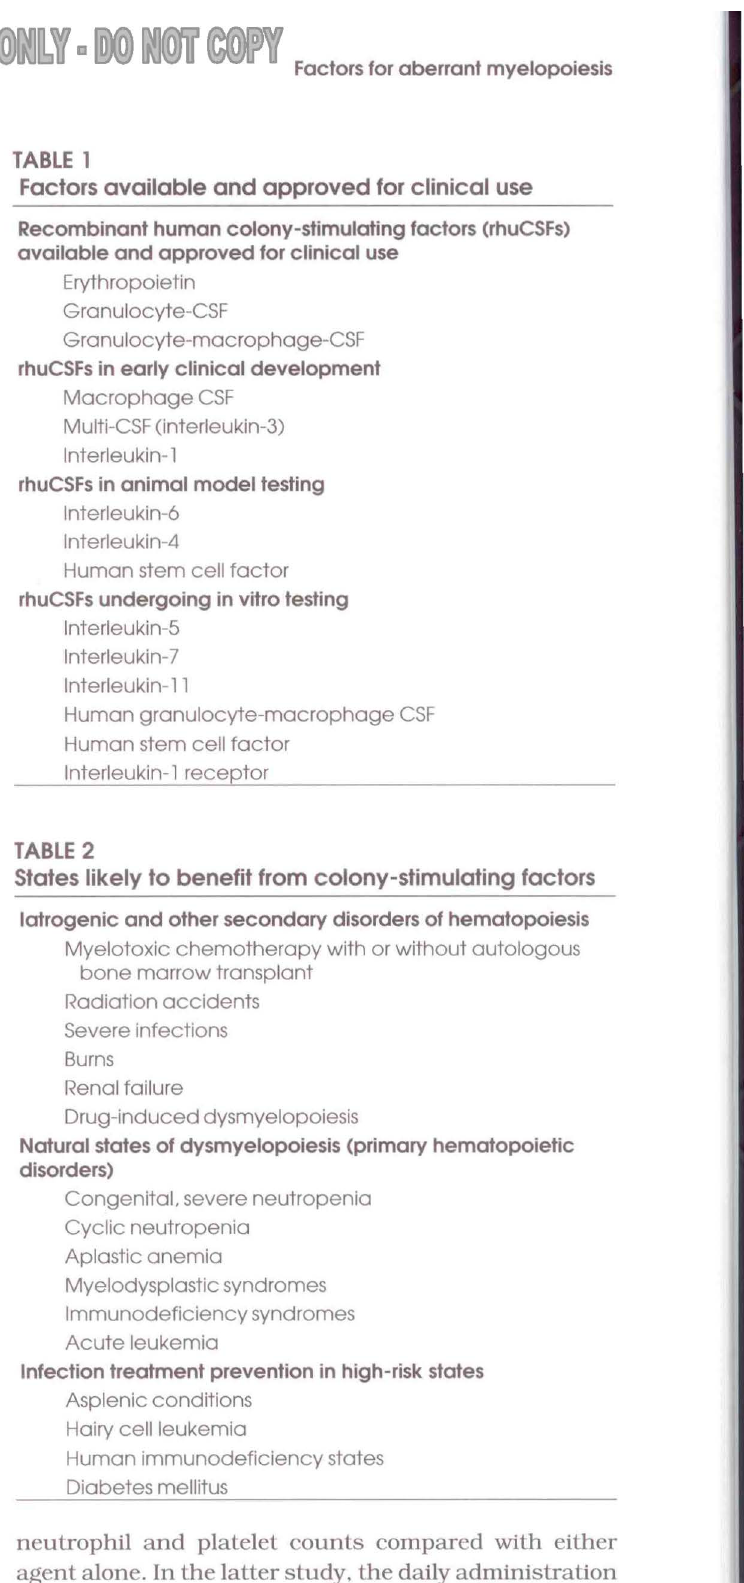
States likely to benefit from colony-stimulating factors Iatrogenic and other secondary disorders of hematopoiesis Myelotoxic chemotherapy with or without autologous bone marrow